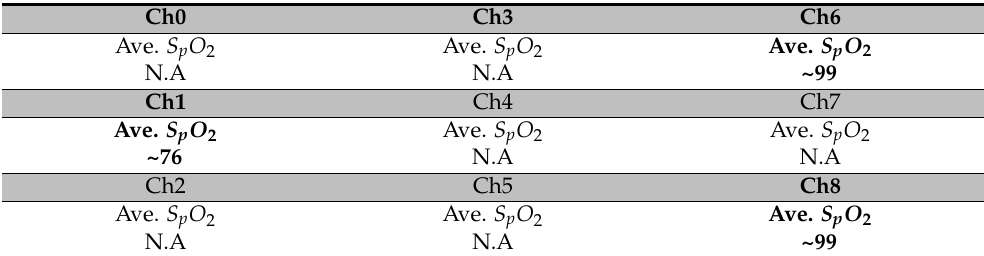
Table 5. The calculated blood oxygen concentration of the array sensors using the design with a sensor spacing of 3 mm.